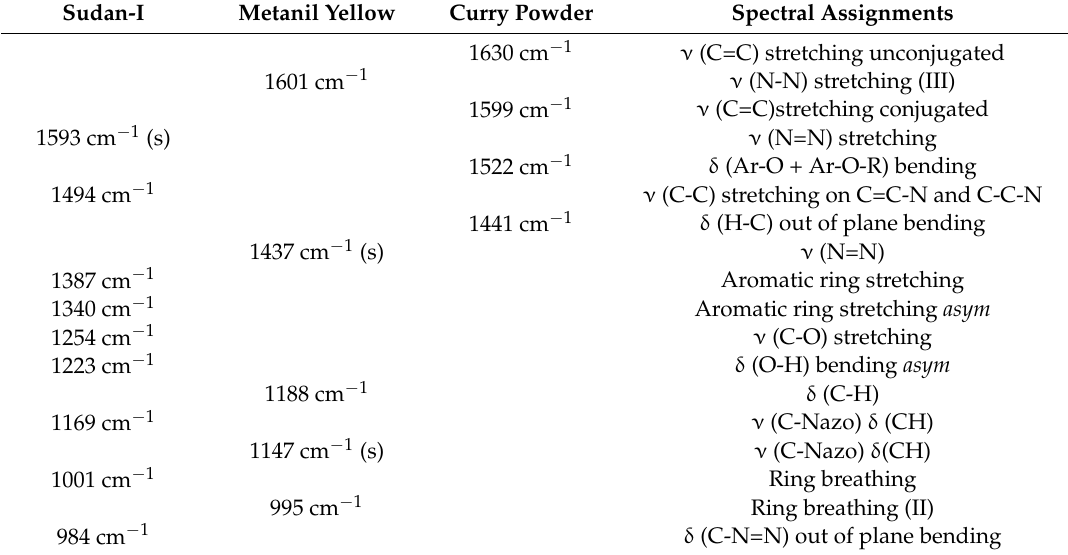
Figure 2. Raman spectra of metanil yellow, Sudan-I, and curry powder. Table 1. Assignment of Raman spectral bands of Sudan-I, metanil yellow, and curry powder [35–41]. Sudan-I Metanil